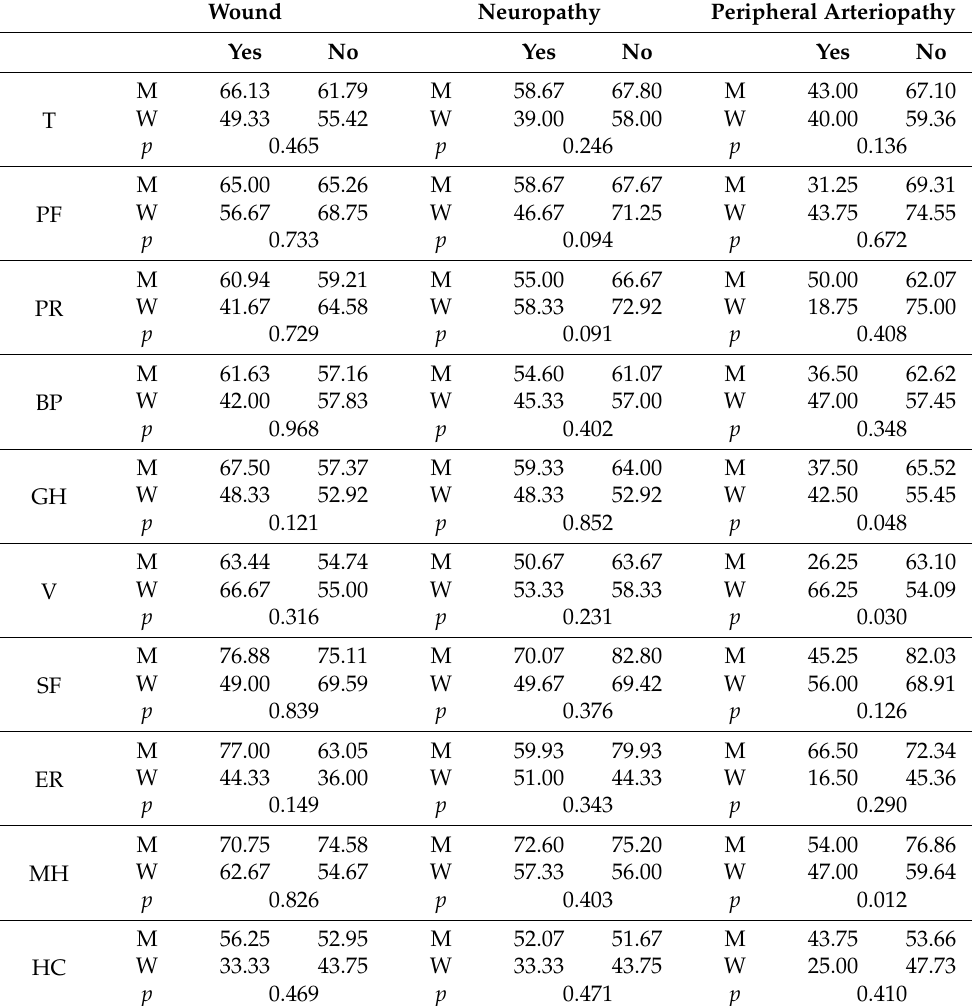
Table 4. SF-36 questionnaire for HRQL dimension descriptive analysis in wound, neuropathy and peripheral arteriopathy presence and differences according to